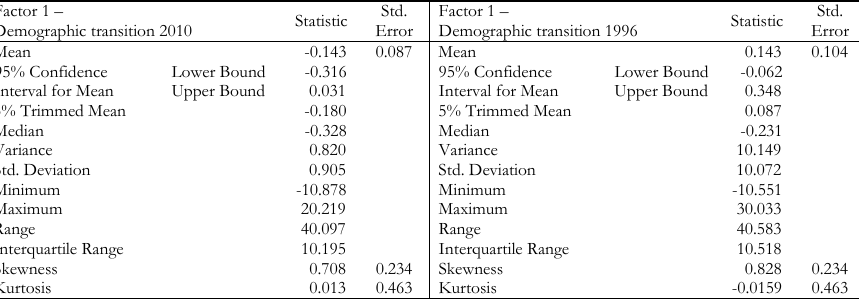
Distribution of scores for factor 1 – Demographic and development convergence